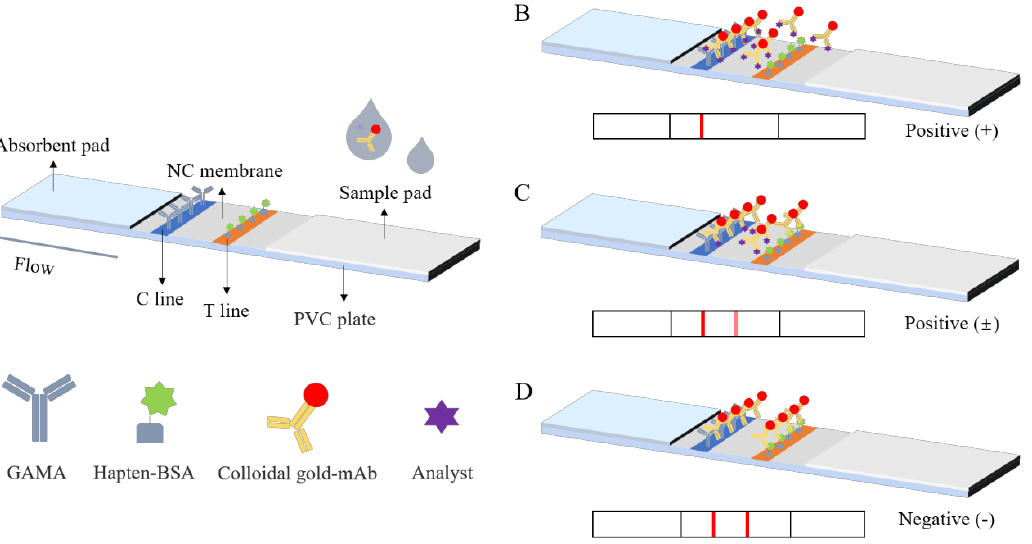
Figure 1. The illustration of the LFIA for CYP determination. ( A ) The structure schematic of the LFIA. ( B – D ) The different results of the LFIA.